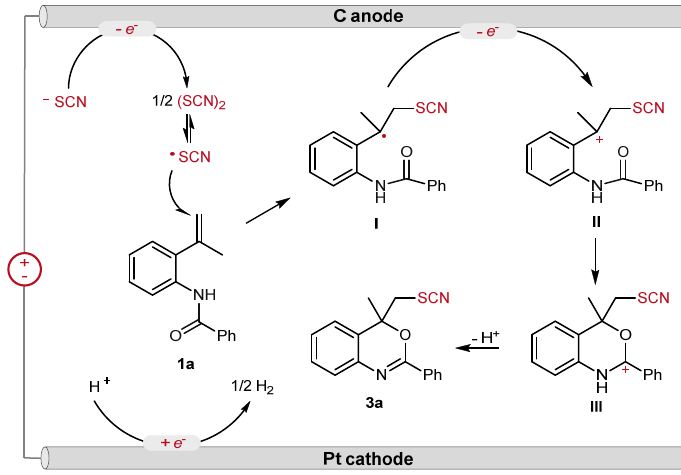
Scheme 3 . Mechanistic studies. ( A ) Radical inhibition experiments. ( B ) CV